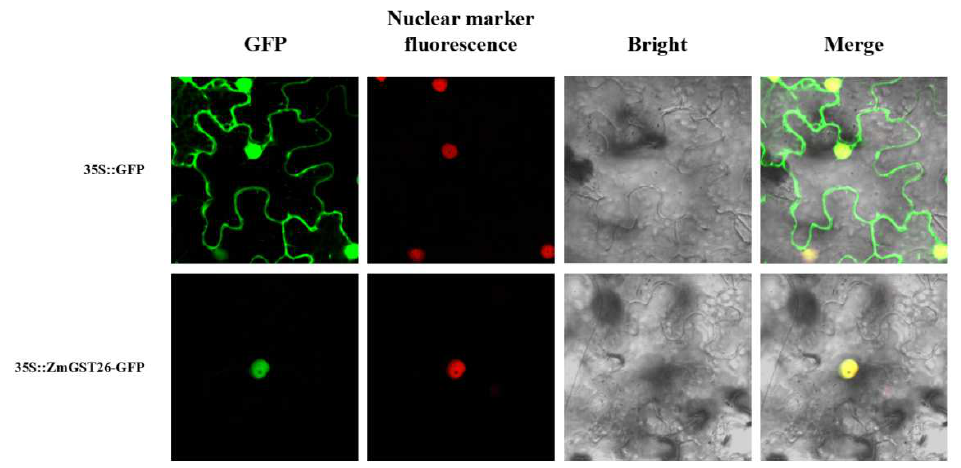
Figure 2. Subcellular localization of ZmGST26 in tobacco epidermal cells. (Bars = 25 µ m). 2.3. Overexpression of ZmGST26 Reduced the Drought Tolerance of Transgenic Arabidopsis